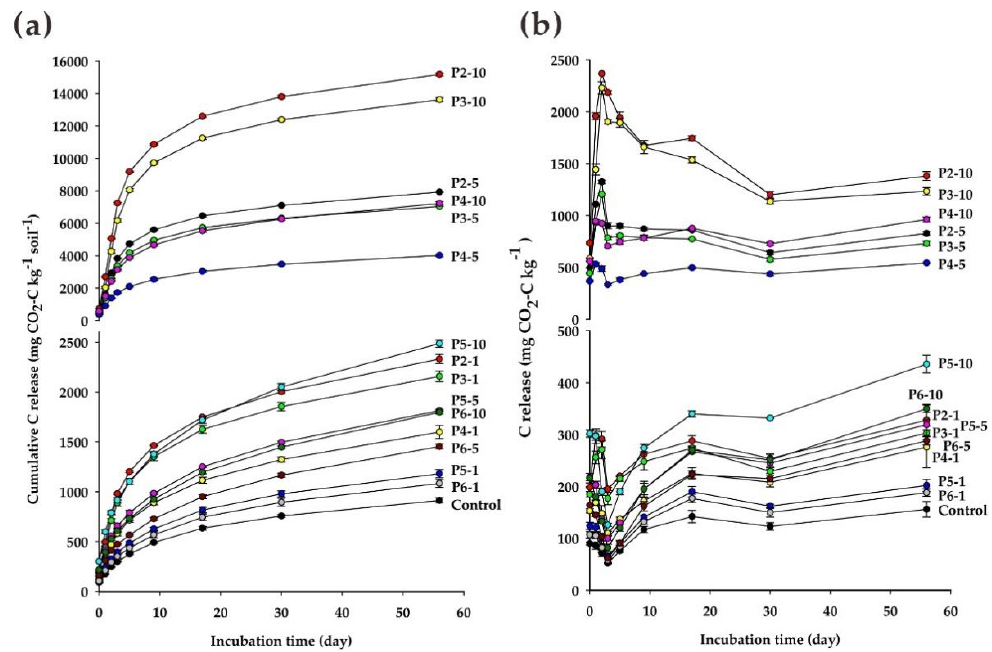
Figure 2. ( a ) Cumulative and ( b ) temporal CO 2 – C release for all treatments from studied soil during the incubation period. P2, P3, P4, P5, and P6 is the poultry litter pyrolyzed at 200, 300, 400, 500, and 600 °C, respectively; − 1 = 1% biochar addition; − 5 = 5% biochar addition; and − 10 = 10% biochar addition. Values represent means ( n = 5) ± standard deviation (error bars). Table 2. Kinetic parameters 1 of carbon mineralization.